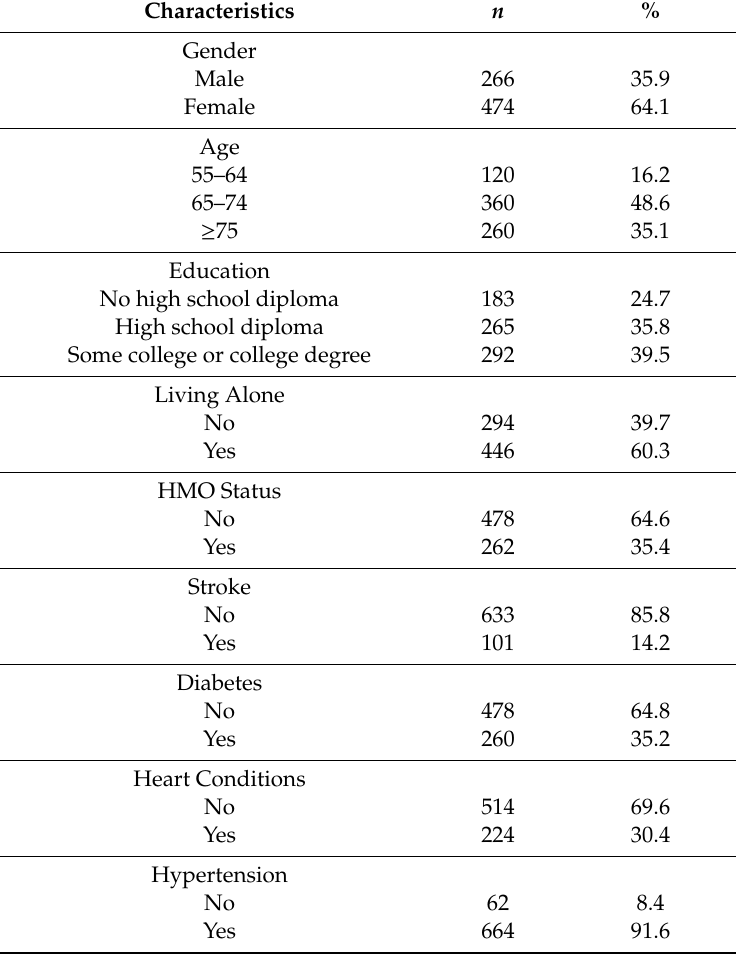
Table 1. Characteristics of middle-aged underserved African-American adults ( n =